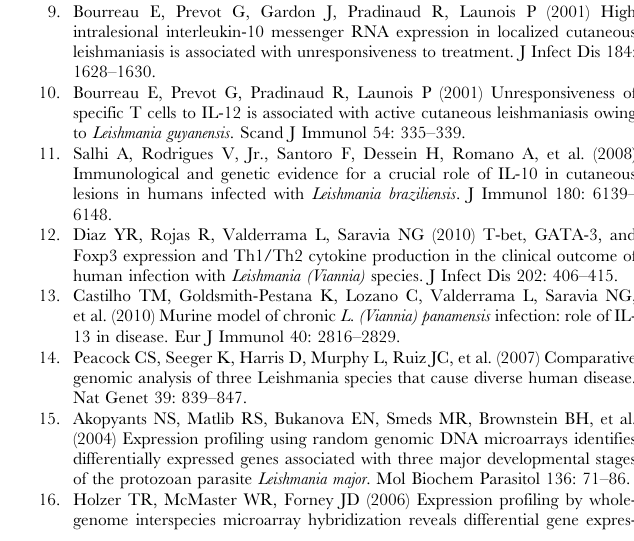
Tables S4 MDM-mRNA level expression post-infection: L. (V.) panamensis – L. (L.) infantum/chagasi . Shown are the genes whose expression differentially regulated in PBMC- derived macrophages as a consequence of infection. For compar- infection to Leishmania (V.) panamensis versus L. (L.) chagasi , the relative microarray fluorescence values from the study of Ettinger infected MDM and either Unchanged or Reduced expression in